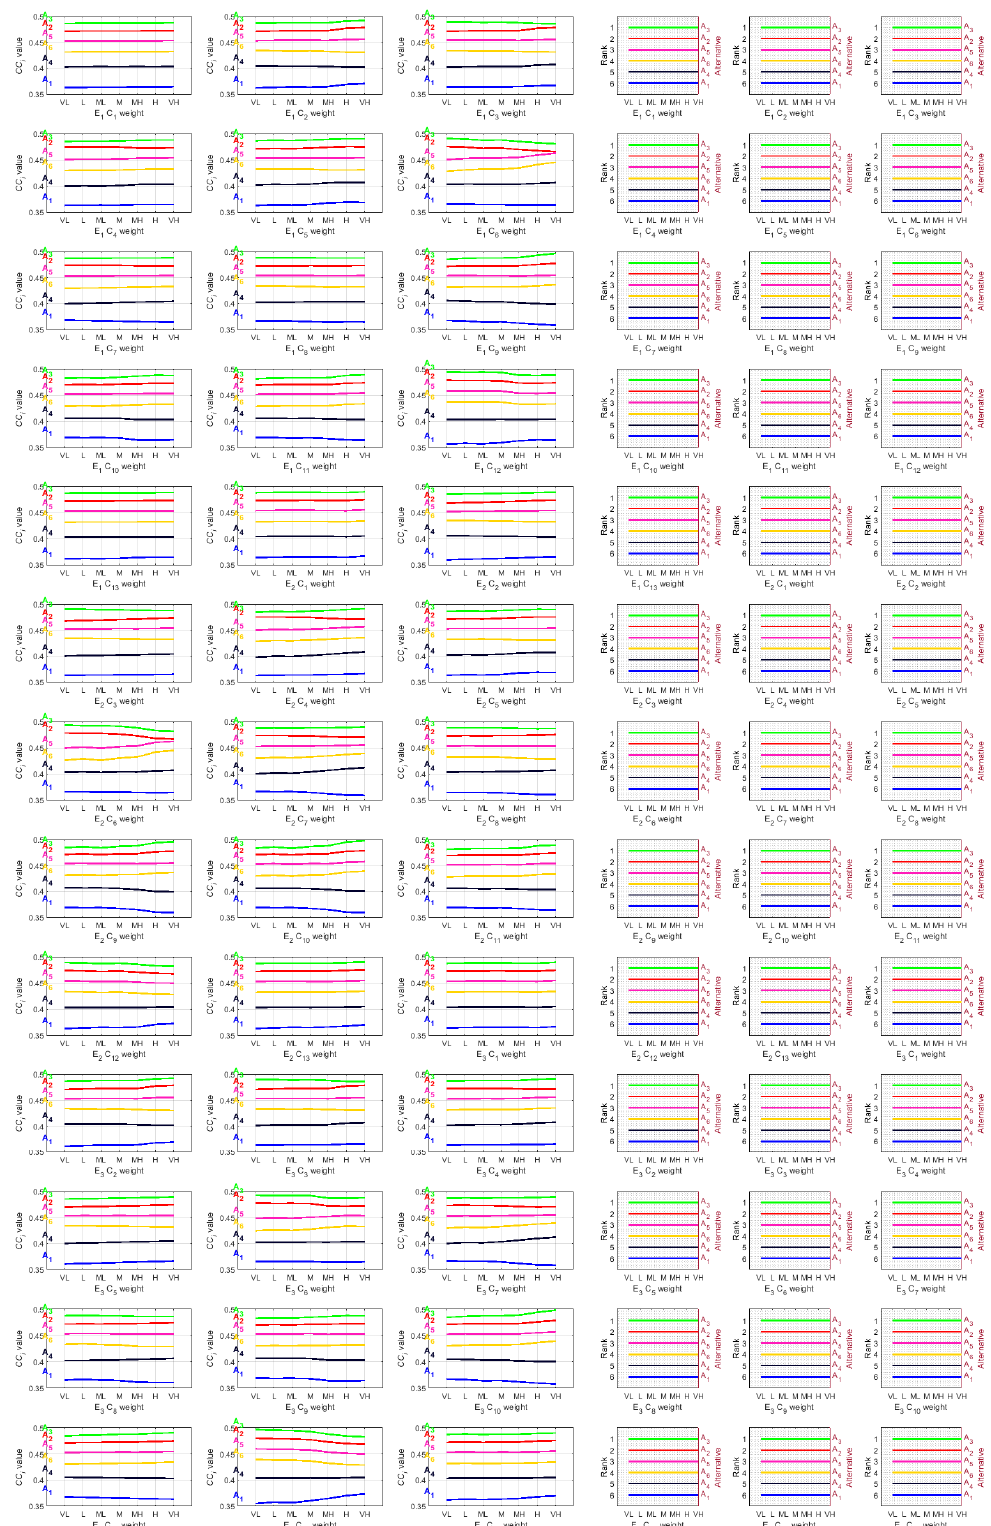
Figure 9. Closeness coefficient values and ranking of alternatives depending on criteria weights.